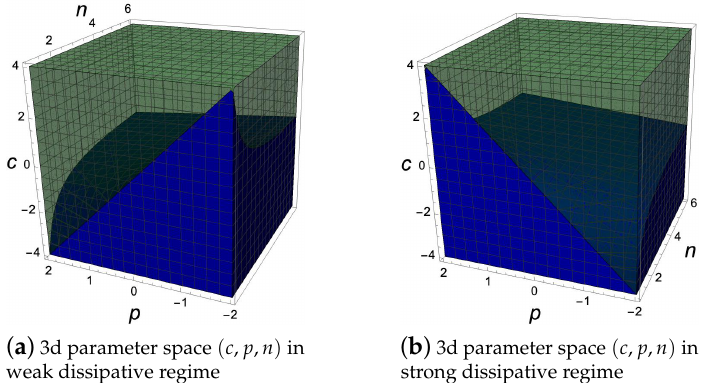
Figure 4. The parameter space in WI for the hilltop-like class of inflaton potentials. The shaded areas indicate that WI has a graceful exit, while empty (white) space indicates where there is no graceful exit. The shaded areas are classified based on the behavior of Q , T / H , and T during inflation when all three increase (dark green), and Q decreases and both T / H and T increase (dark blue). Figure based on